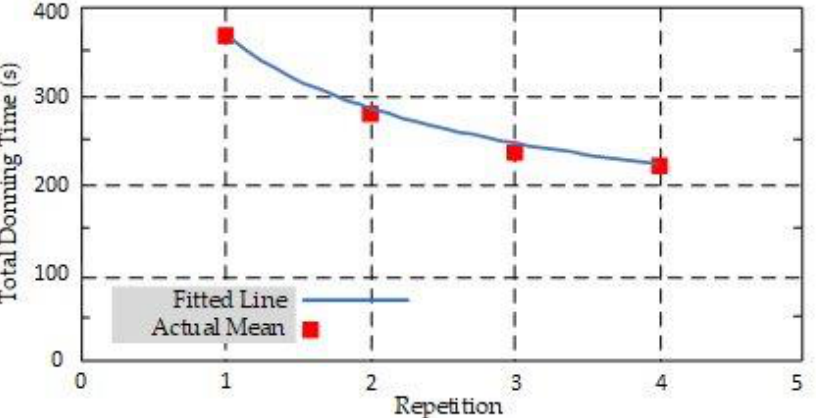
Figure 6. The learning curve for total time to don and adjust a harness based on 22 subjects.